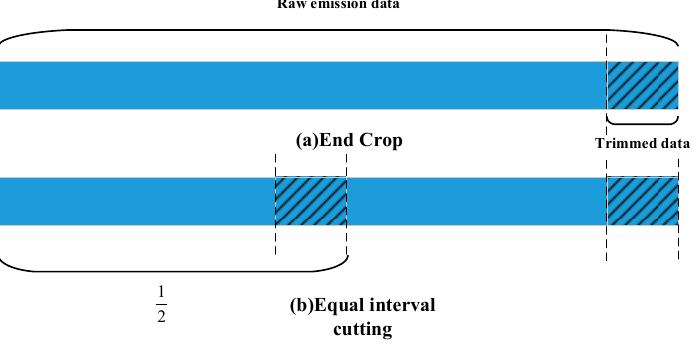
Figure 10. Data cutting method at the transmitting end. The results of the clipping experiment at the end of the transmitter data are shown in Figure 11a below.